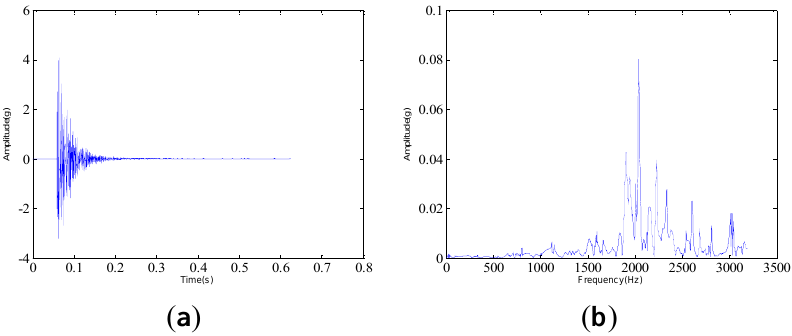
Figure 7. The measured vibration signal under the assembly condition 1 and the corresponding frequency spectrum. ( a ) vibration signal; ( b ) frequency spectrum.